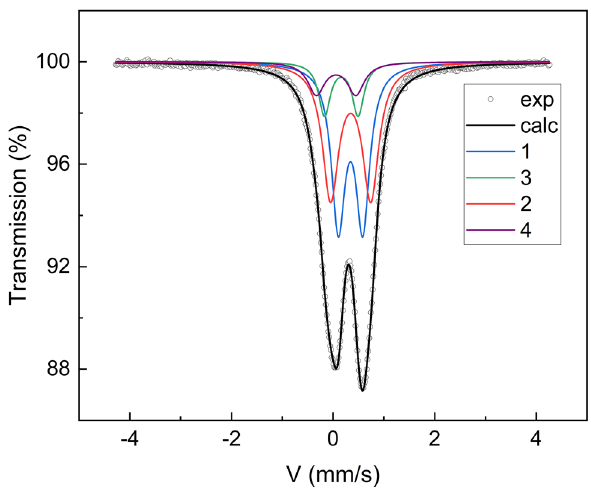
Figure 3. 57 Fe transmission Mössbauer effect spectrum of the devitrified glass containing Fe 7 P 11 O 38 and traces of FePO 4 at room temperature. The fitted subspectral components (1–4) are designated as in Table 1.